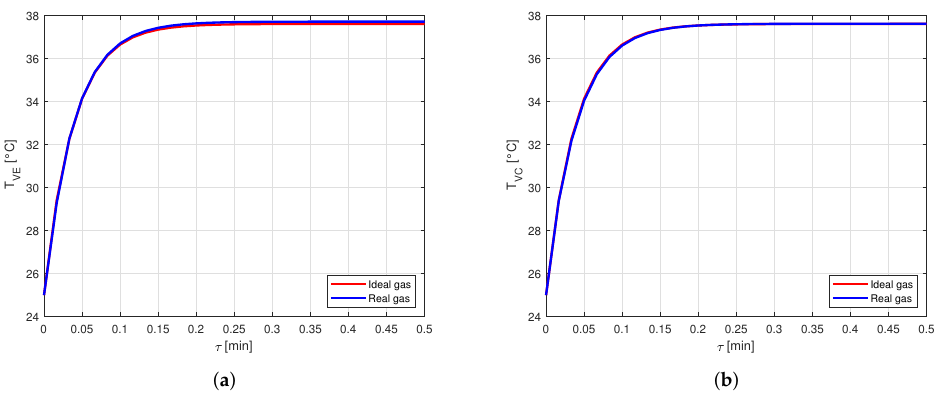
Figure 15. Comparison between the vapor temperatures obtained by modeling the vapor as ideal or real gas, in a copper-HFC134a heat pipe. ( a ) Comparison of the vapor temperatures at the evaporator. ( b ) Comparison of the vapor temperatures at the condenser.